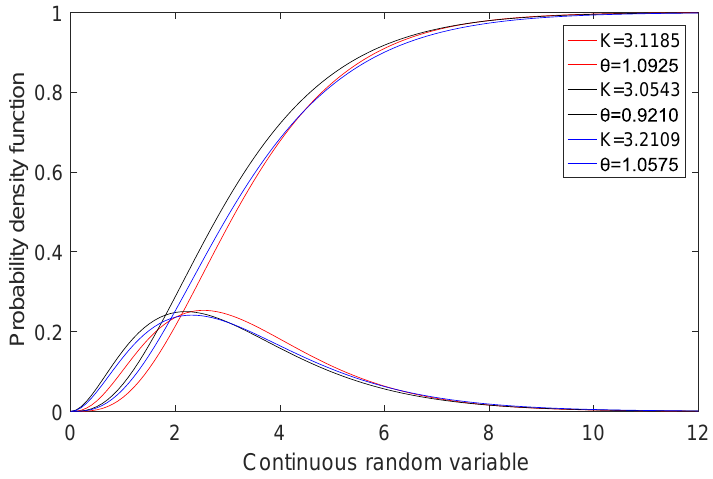
Figure 6. Schematic diagram of gamma distribution of control turbines.